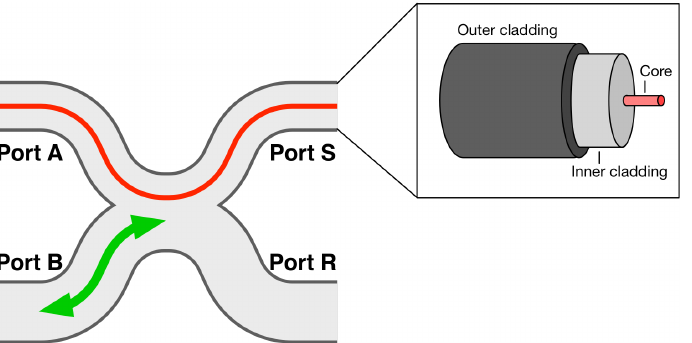
Figure 1. Schematics of a DCFC showing the single-mode signal in red and the direction of transfer of some multimode signals in green. Inset: concentric structures of a